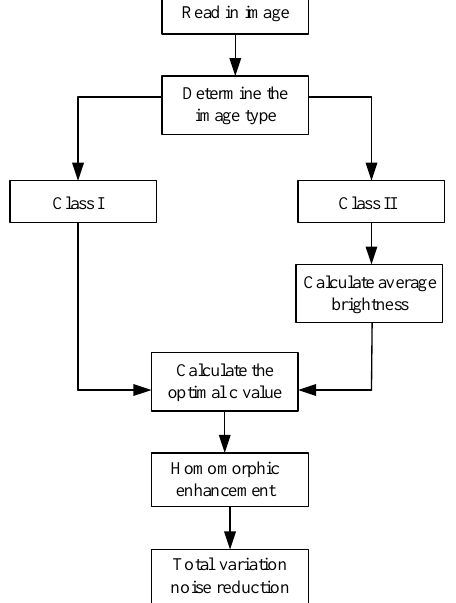
Figure 11. Flowchart of the adaptive algorithm.